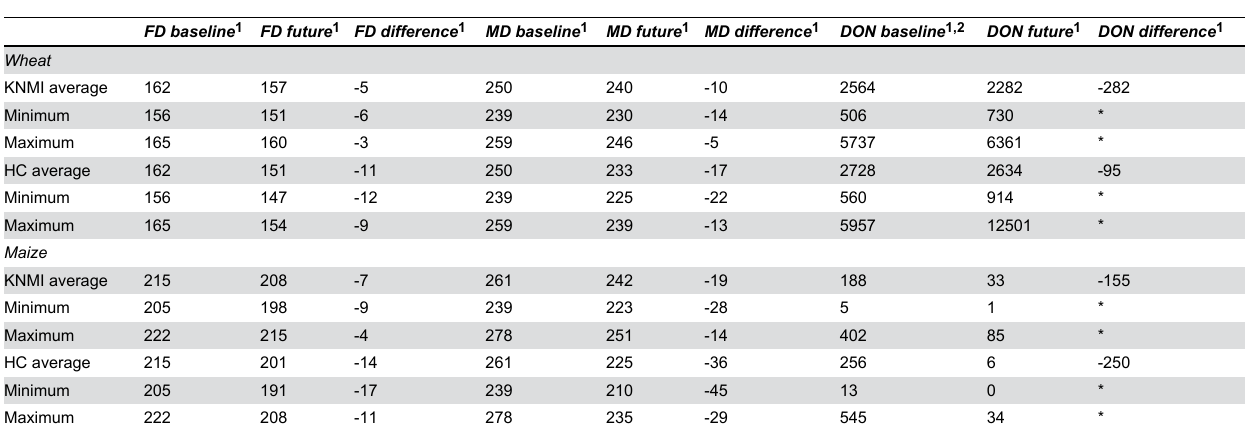
Table 2. Summary of project climate change effects on flowering date, full maturity date and concentrations of deoxynivalenol in winter wheat and maize grown in the Netherlands, based on KNMI and HC climate model data.